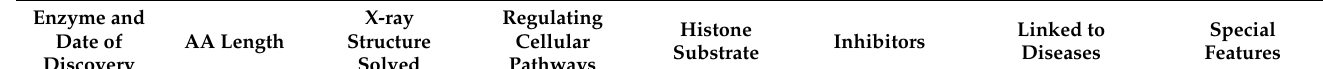
Table 1. Structure and function of SMYD proteins and the therapeutic targets of SMYD